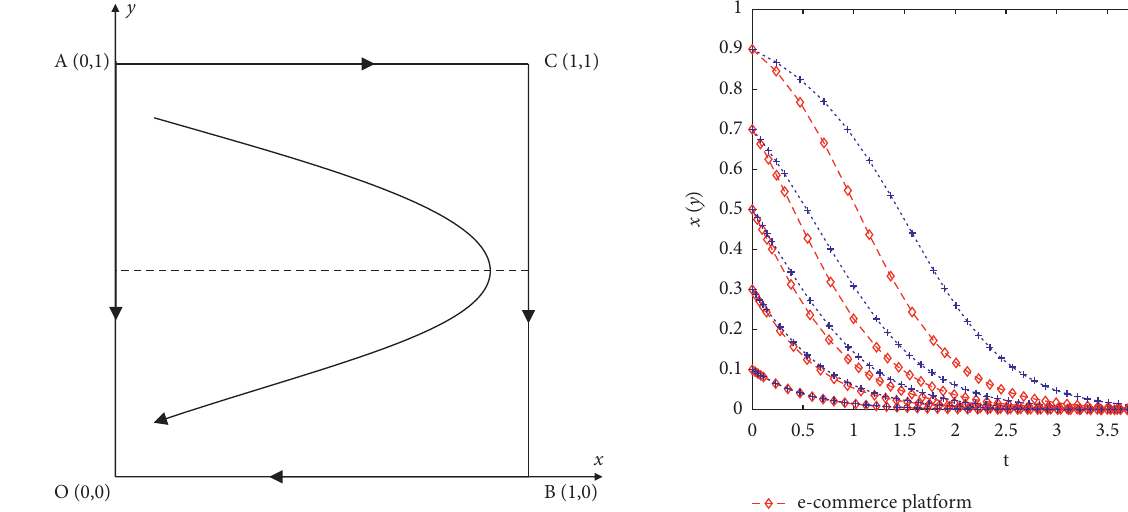
Figure 4: Phase diagram of Model IV. Table 7: The stability analysis of Model V.